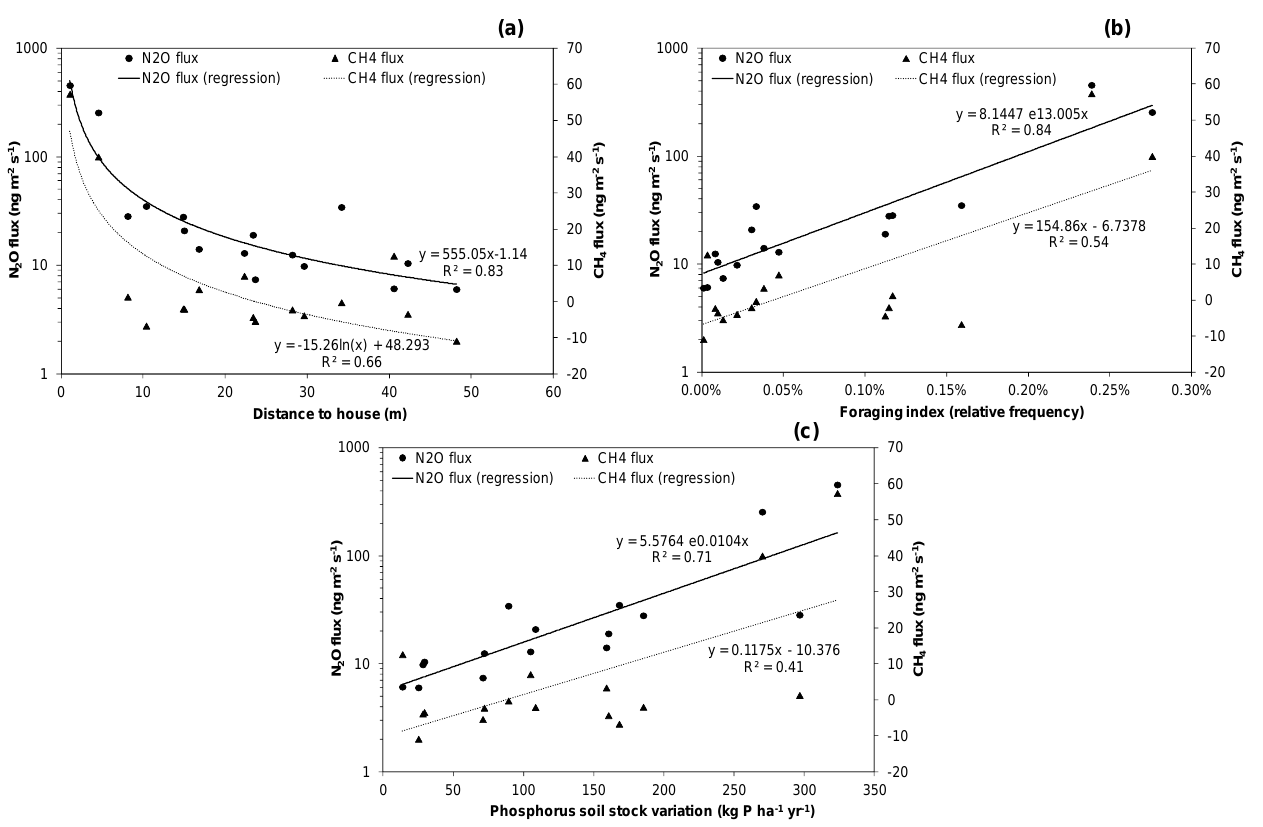
O and CH chamber fluxes and control 2 4